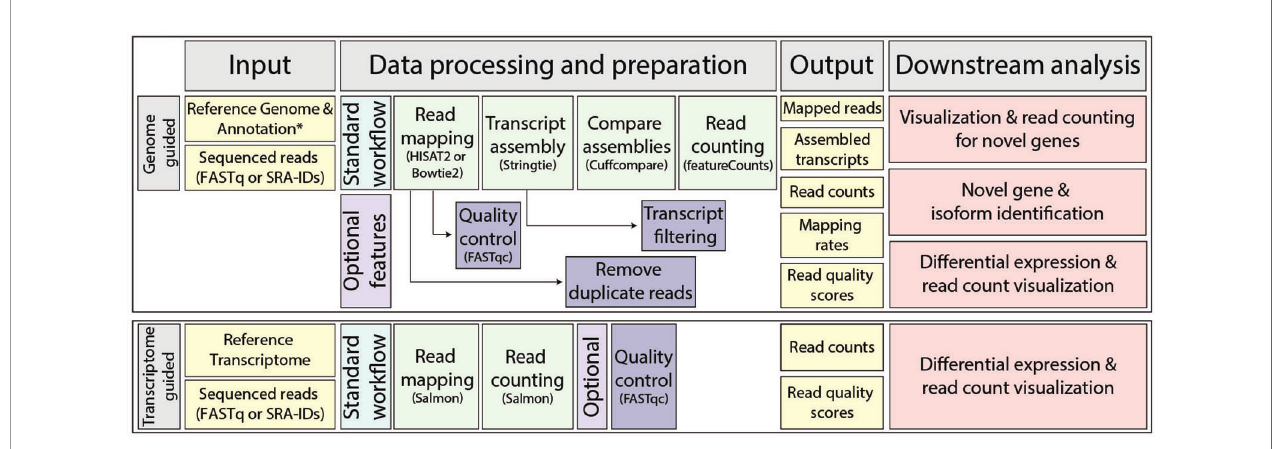
FIGURE 2 | Read mapping and transcript assembly (RMTA) work fl ow with suggested downstream analyses. The standard RMTA work fl ow consists of read mapping by either HISAT2 or Bowtie 2, transcript assembly by StringTie, assembly comparison to the reference annotation by Cuffcompareto identify novel transcripts, and then read counting by featureCounts. Several optional features are included, such as the ability to perform quality control on RNA-sequencing (RNA- seq) data with FastQC, fi ltering of lowly expressed transcripts, and removal of duplicate reads (Bowtie 2 only). Output is listed, and are ready for downstream analyses such as those